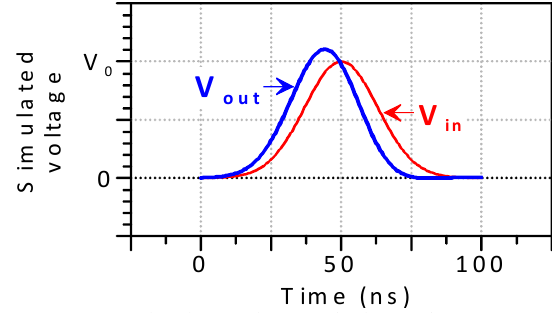
Figure 8: NGD circuit transient analysis results.